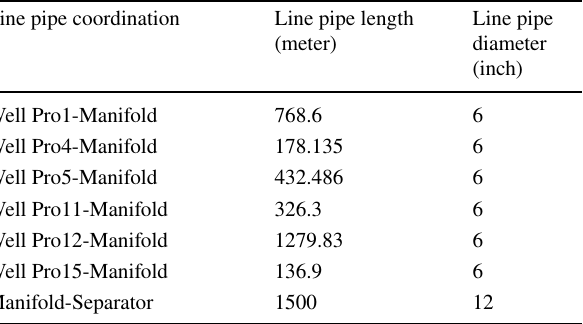
Table 4 Length and size of pipelines from each well to manifold and from manifold to separator